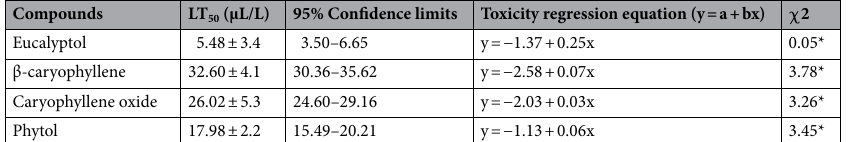
Table 6. Larvicidal activity of the four individual compounds mostly found from the seven essential oils of Ar. argyi in China against the 4th instar larva of An. sinensis . *Significant at p < 0.05.